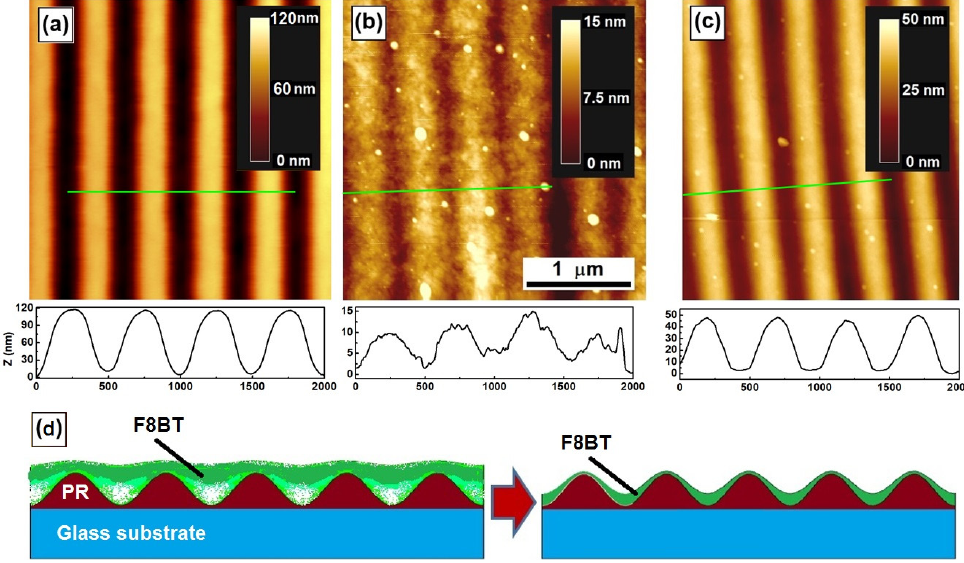
Figure 2. AFM images of: ( a ) the photoresist (PR) grating; and the PR grating spin ‐ coated with F8BT before ( b ) and after ( c ) the laser ‐ induced cross ‐ linking process. ( d ) A schematic illustration of the morphologic modification by laser ‐ induced cross ‐ linking. The lighter colors in the left panel indicate smaller density of F8BT molecules or less filled space before cross ‐ linking.